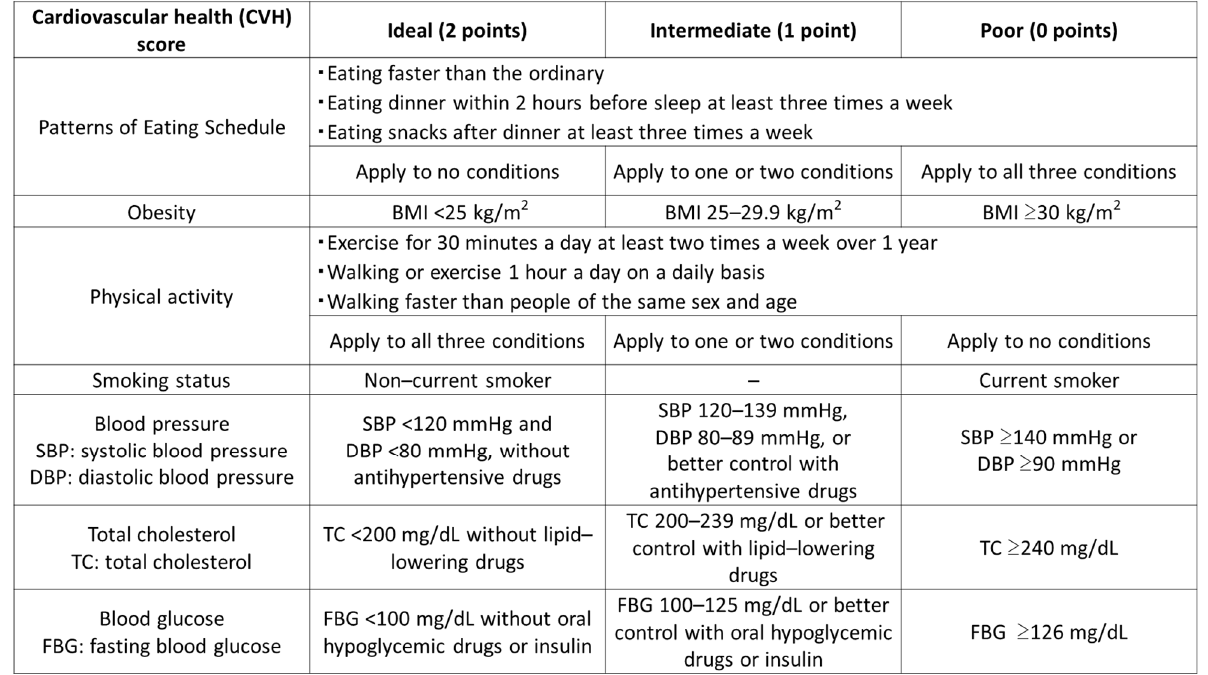
Figure 2. Cardiovascular health (CVH) scoring. The CVH score included seven modifiable components (patterns of eating schedule, obesity, physical activity, smoking status, blood pressure, total cholesterol, and blood glucose). We referred to the data of health checkups from questionnaires, anthropometric measurements, and blood tests. BMI, body mass index.